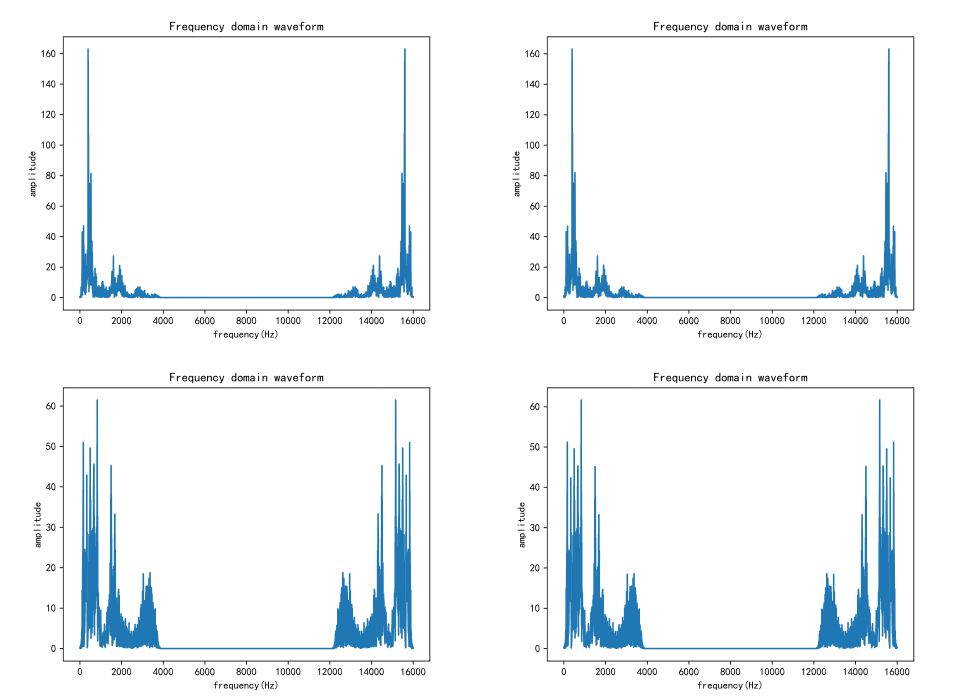
Figure 12. The frequency-domain waveform. The left column is the frequency-domain waveform of the secret audios, and the right column is the frequency-domain waveform of the reconstructed secret